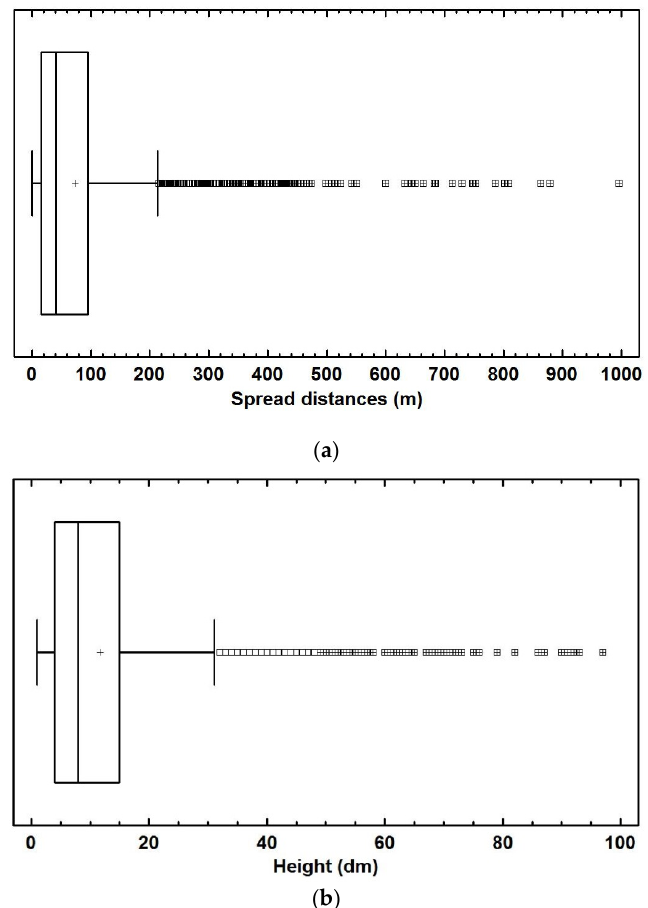
Figure 2. ( a ) Box ‐ and whisker plot of spread distances distribution for Sitka spruce in coastal Norway. The box encloses the middle 50% of observations. The median is represented as a vertical line inside the box and + displays the mean. The left whisker is drawn from lower quartile to the smallest observation, while the right whisker is drawn from the upper quartile to the largest observation. Individual points are regarded as outliers; ( b ) Box ‐ and whisker plot of height distribution for Sitka spruce saplings. The box encloses the middle 50% of observations. The median is represented as a vertical line inside the box and + shows the mean. The left whisker is drawn from lower quartile to the smallest observation, while the right whisker is drawn from the upper quartile to the largest observation. Individual points are regarded as outliers. Sapling height varied from 0.1 m up to 10 m with a mean of 1.3 m. Some of the trees higher than 4 m were cone bearing.